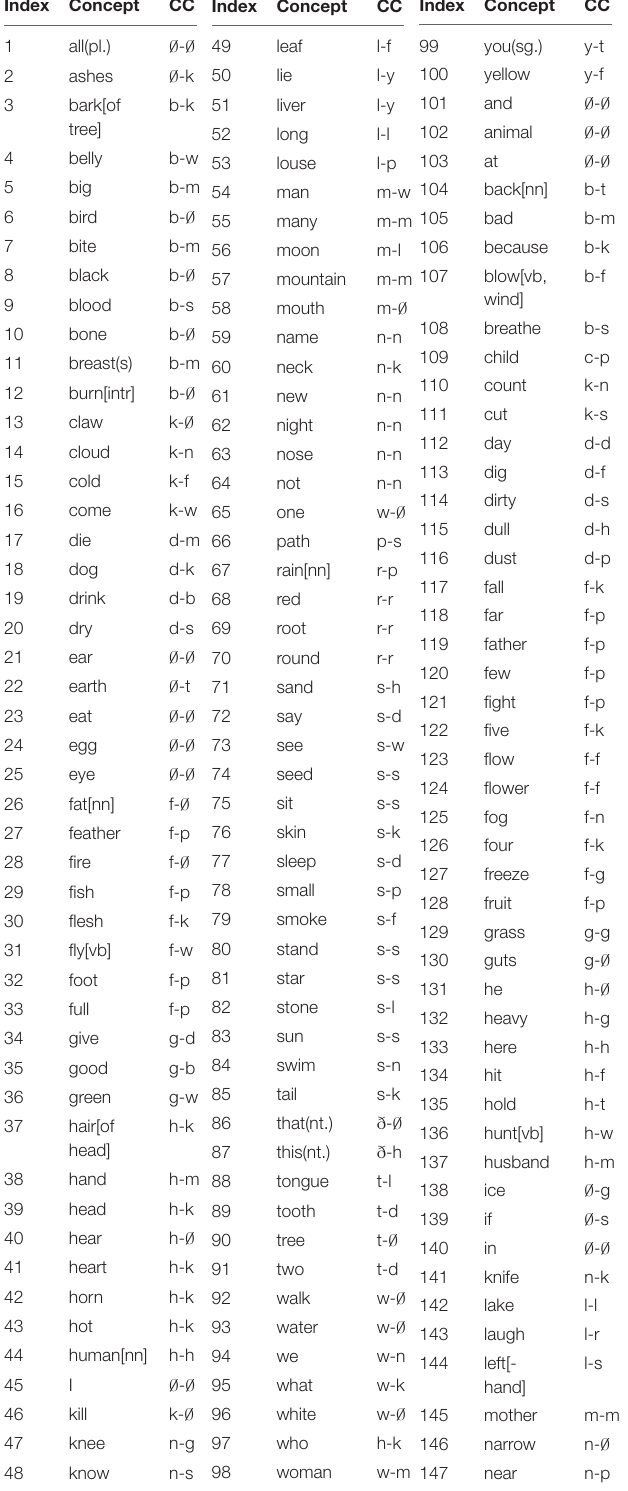
TABLE 2 | Word-initial consonant correspondences (CCs) between English (left) and Latin (right) (extracted from Ringe, 1992) following the Swadesh 100- and 200-word lists.